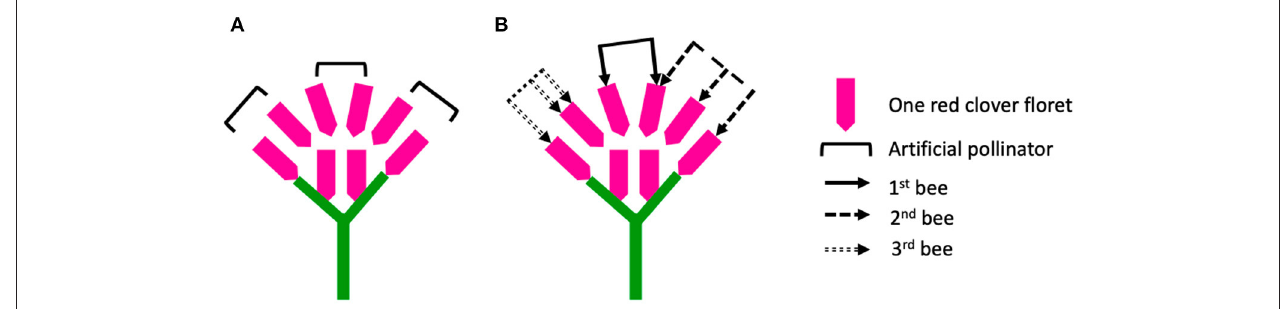
FIGURE 8 | Illustration of a simplified red clover flower head containing eight florets per flower head. Six of the florets were pollinated, but under two different pollination approaches: (A) hand pollination, where each artificial pollinator had a visitation rate of two without re-visiting the florets, and (B) open pollination (three bees visiting the flower head subsequently), where the first bee had a visitation rate of two by visiting two different florets, the second bee had a visitation rate of three but revisited one floret that had been visited by the first bee, the third bee had a visitation rate of three but revisited one floret that had been visited by